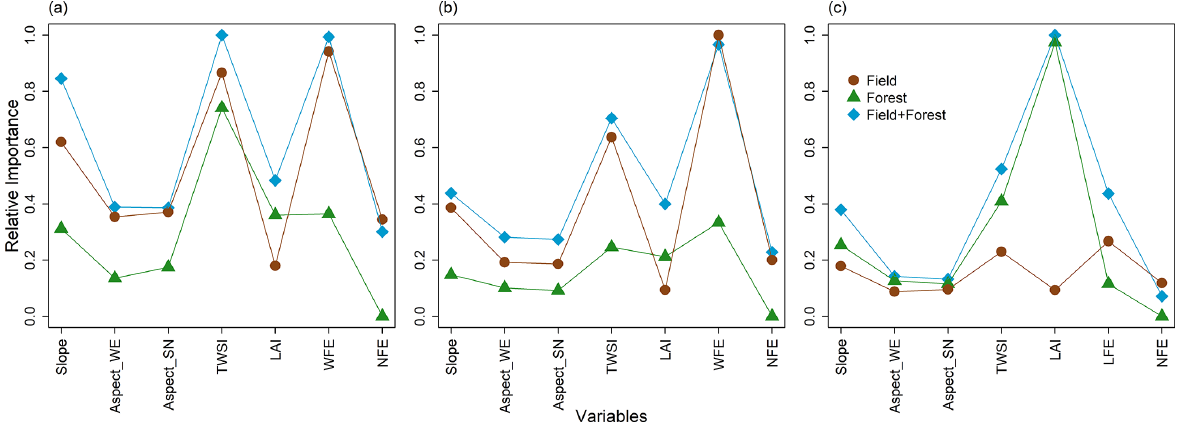
Figure 7. Relative importance of variables (scaled between 0 and 1) in predicting snow depths. (a) Sainte-Marthe, (b) Saint-Maurice, and (c)